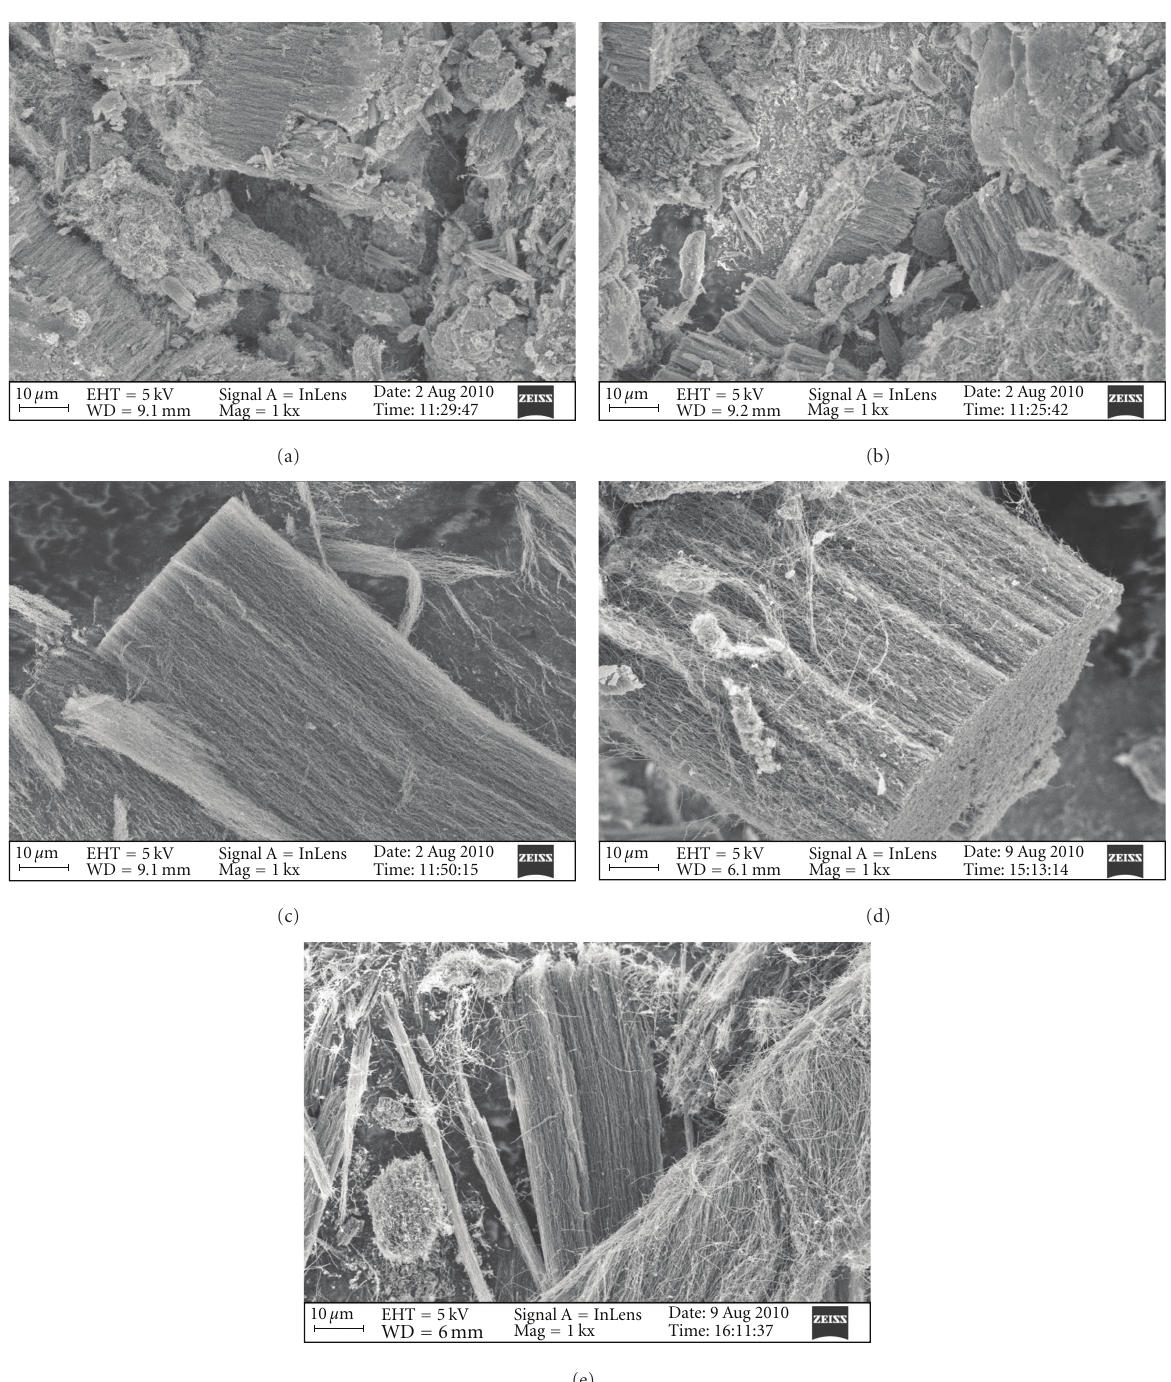
Figure 2: FESEM micrographs of aligned CNT at di ff erent synthesis time (a) 700, (b) 750, (c) 800, (d) 850, and (e) 900 ◦ C.